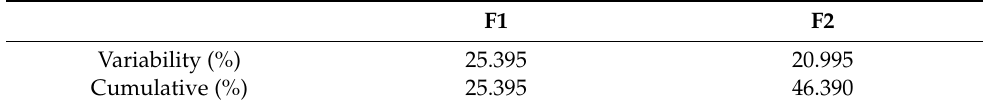
Table 3. Percentage of variance after Varimax rotation. Variability